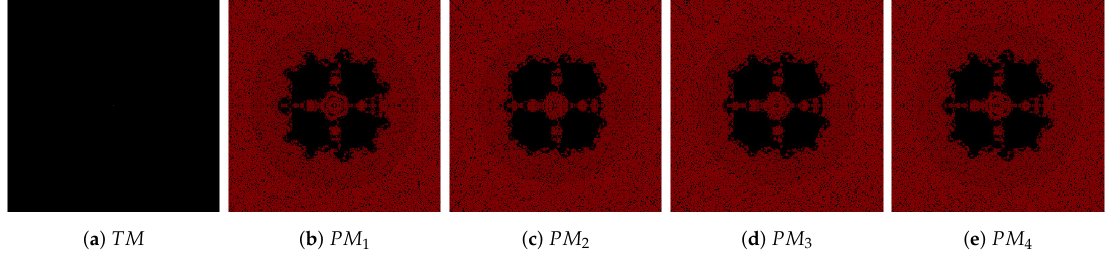
Figure 3. Comparisons of the convergence plane at β = − 0.01 for Problem 2 with m =